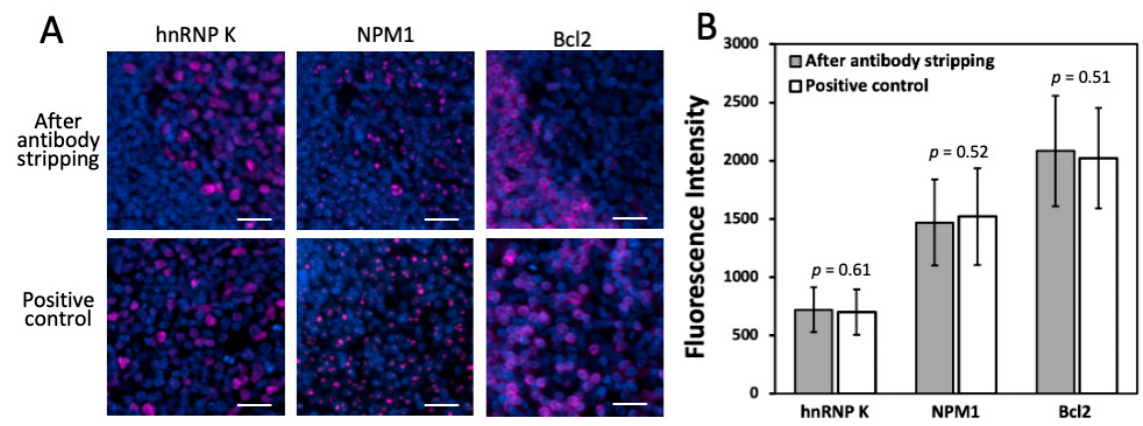
Figure 3. ( A ) Protein hnRNP K, NPM1 and Bcl2 are stained with CFT in the same FFPE tonsil tissue after 10, 15 and 20 cycles of antibody stripping, respectively (top row). These proteins are also stained in three different FFPE tonsil tissues by the conventional tyramide signal amplification approach (bottom row). ( B ) Comparison of the staining intensities obtained after antibody stripping and by conventional immunofluorescence ( n = 50 positions). Error bars, standard deviation. Scale bars, 20 μ m.